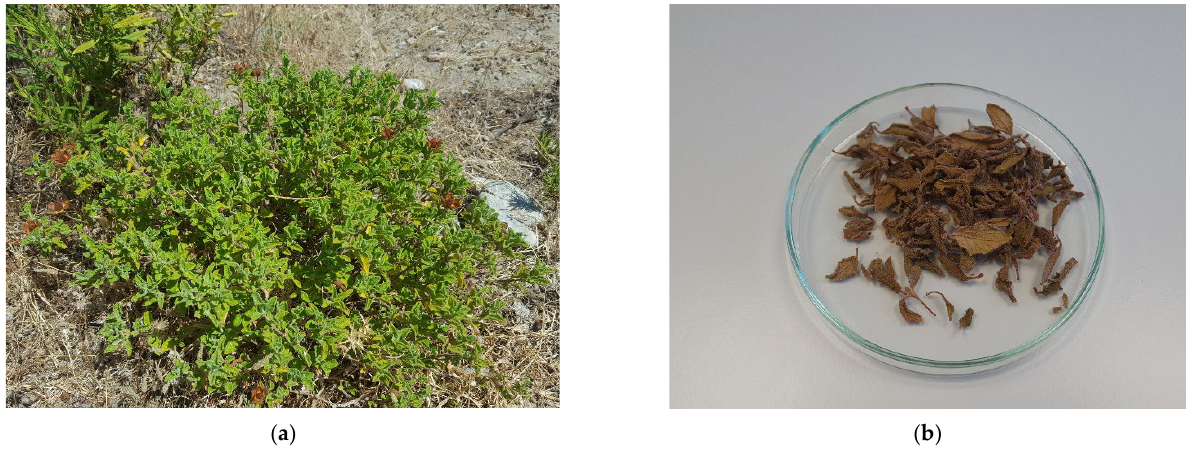
Figure 4. ( a ) Cistus salviifolius at location Petaloudes; ( b ) the appearance of the herbal